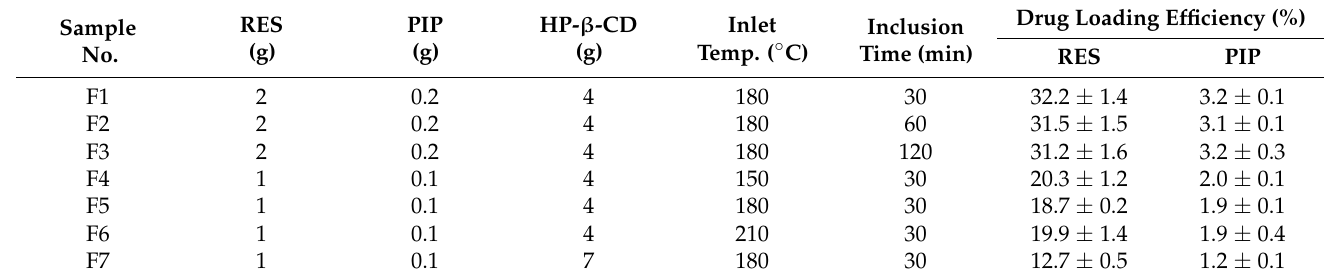
Table 1. Formulations of the feed solutions and process parameters used for